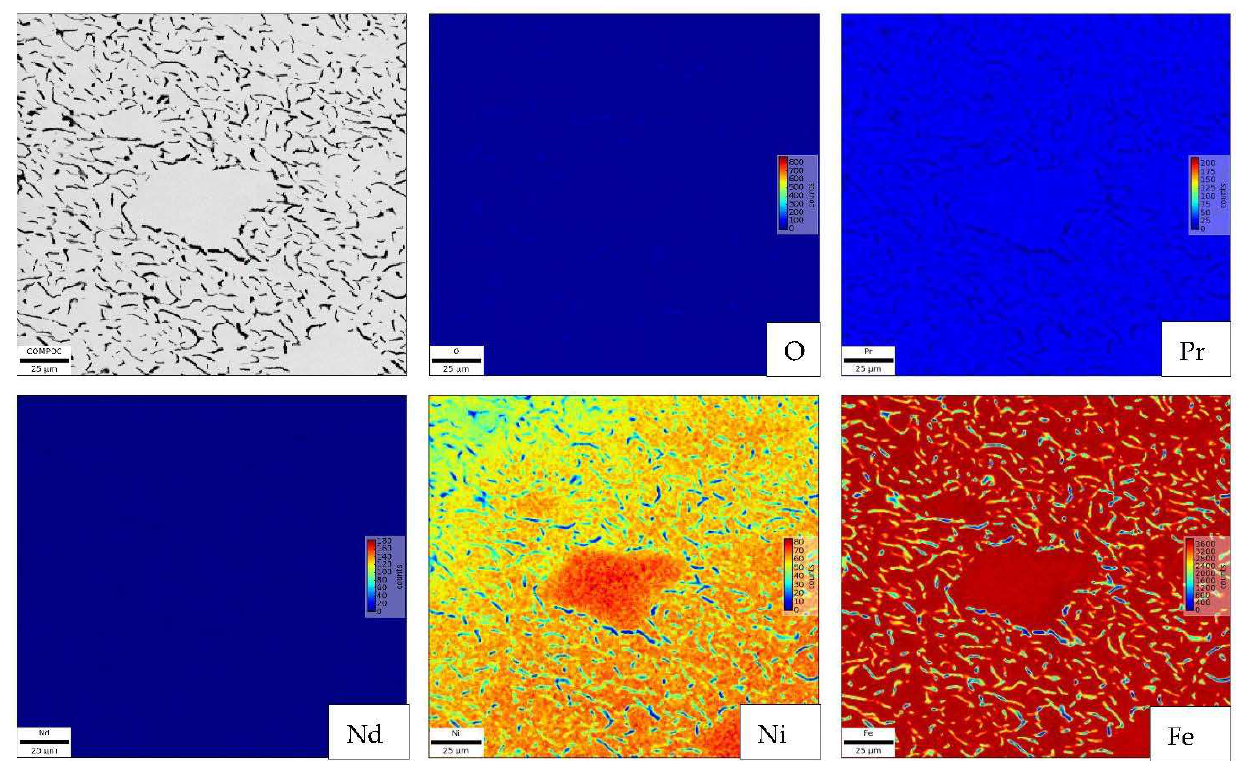
Figure 9. SEM-EDS mapping of metal phase from V3.